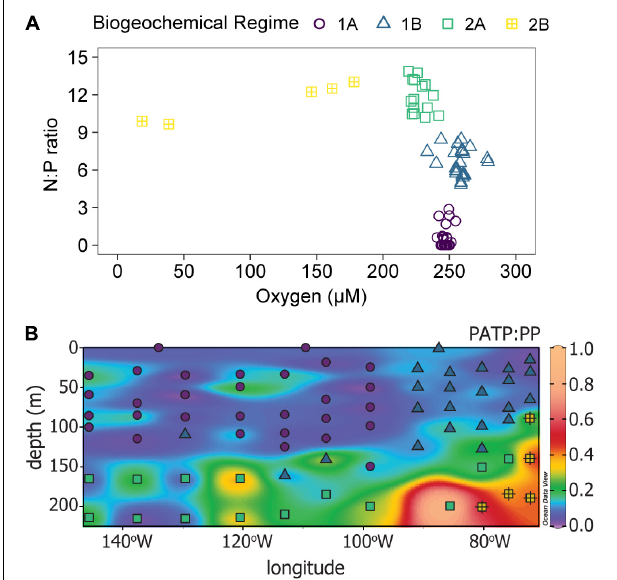
FIGURE 4 | Identification of distinct biogeochemical regimes, labeled regime 1A (purple circles), regime 1B (blue triangles), regime 2A (green squares), and regime 2B (yellow squares with crosses). (A) A scatter plot of the N:P ratio vs. oxygen concentration for the 81 sample locations across the 15 stations where PATP was sampled, Figure 1 . (B) Distribution of the four biogeochemical regimes along the transect (symbols) over the distribution of the PATP:PP ratio (colored